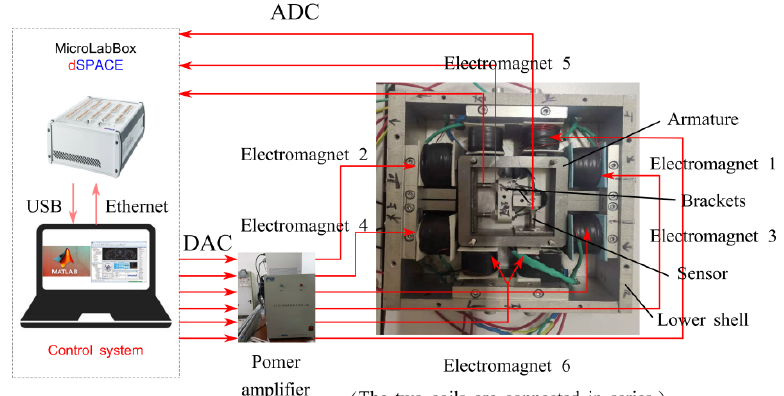
Figure 8. Control system hardware.